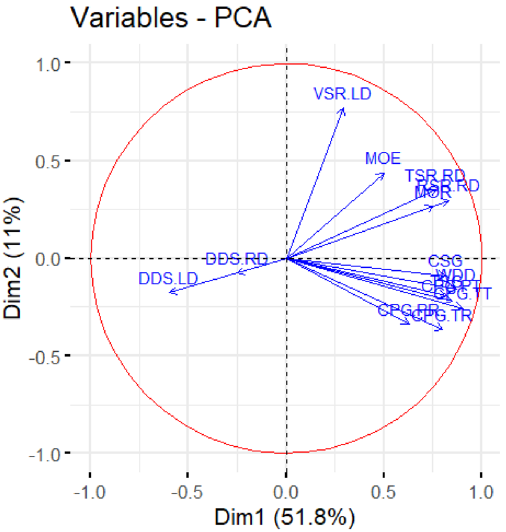
Figure 3. Sequence diagram plot of PCA analysis showing the relationship among physical properties of